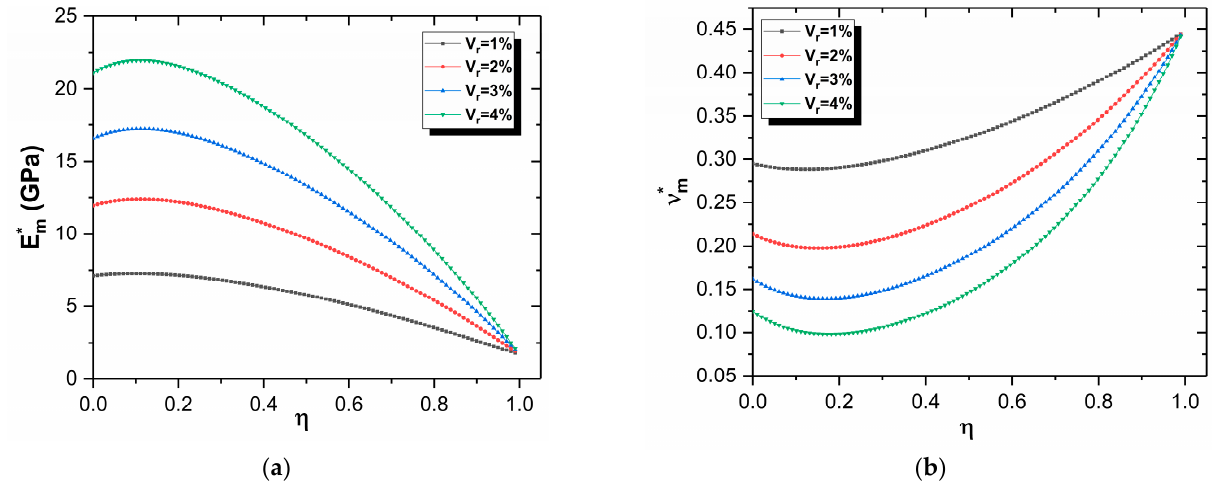
Figure 18. Effective elastic moduli of composite reinforced by randomly GNP inclusion in PP matrix, in function of η for µ = 0.35 with a maximum of Young’s modulus E ∗ m and minimum of Poisson ratio ν ∗ m : ( a ) effective Young’s modulus E ∗ m ; and ( b ) effective Poisson’s ratio ν ∗ m